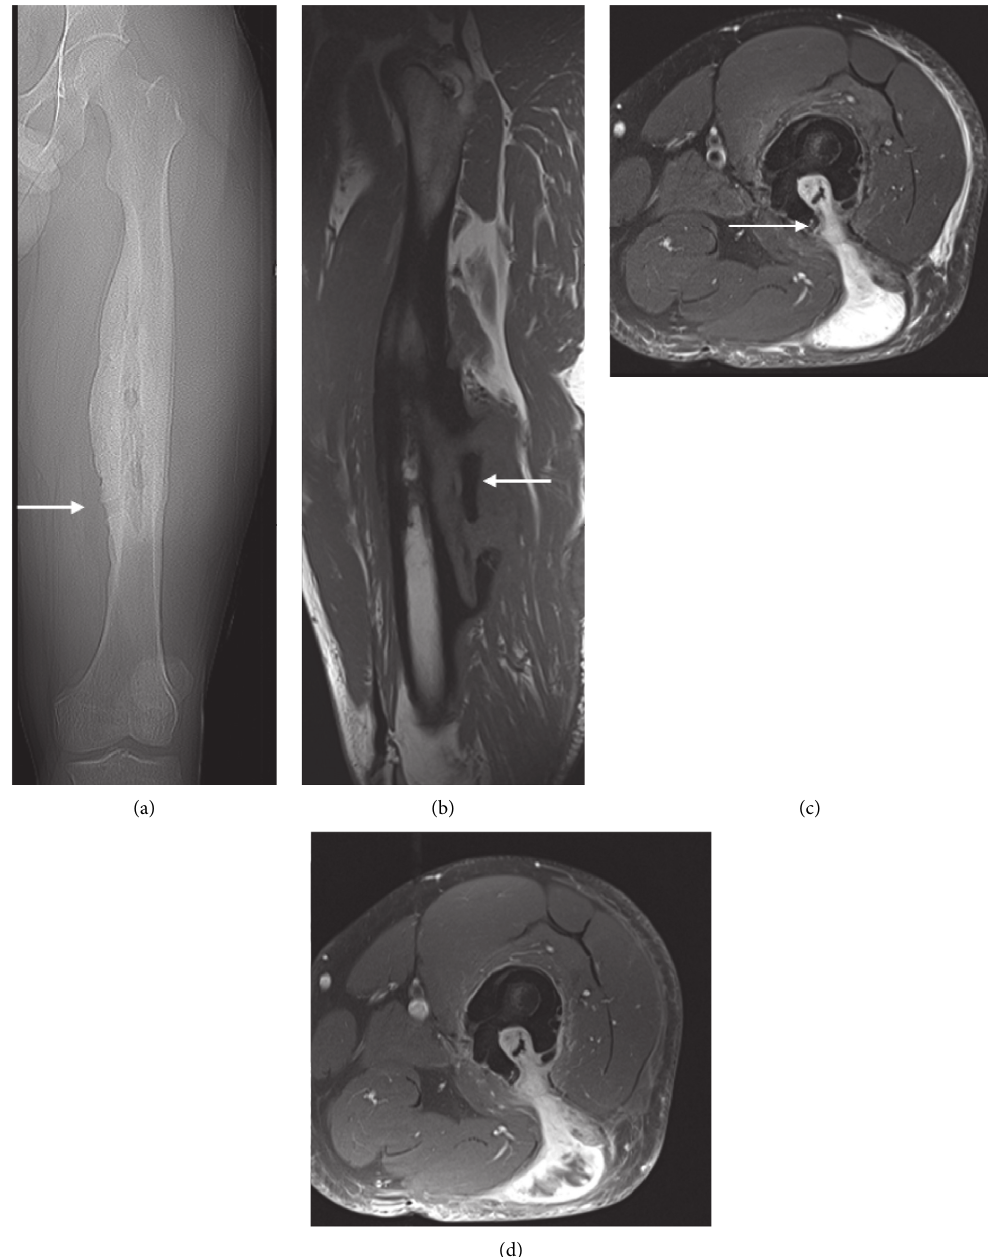
Figure 5: A 30-year-old systemically well man with chronic osteomyelitis who initially presented with an enlarging mass in the posterior thigh. The planning CT (a) showed femoral shaft sclerosis, periosteal thickening, and cortical expansion which is worse medially. A lucent tract at the inferior border of the abnormal bone extends from the medulla to the cortex, consistent with a sinus tract (arrow). Sagittal T1 (b) demonstrating the extent of the osteomyelitis with sequestrum posteroinferiorly (arrow). Axial PDFS (c) and T1FS postcontrast (d) MRI shows the new bone formation or involucrum attempting to envelop the infection. A cloaca or sinus tract involving the posterolateral thigh discharges into the subcutaneous plane, accounting for the presentation (C